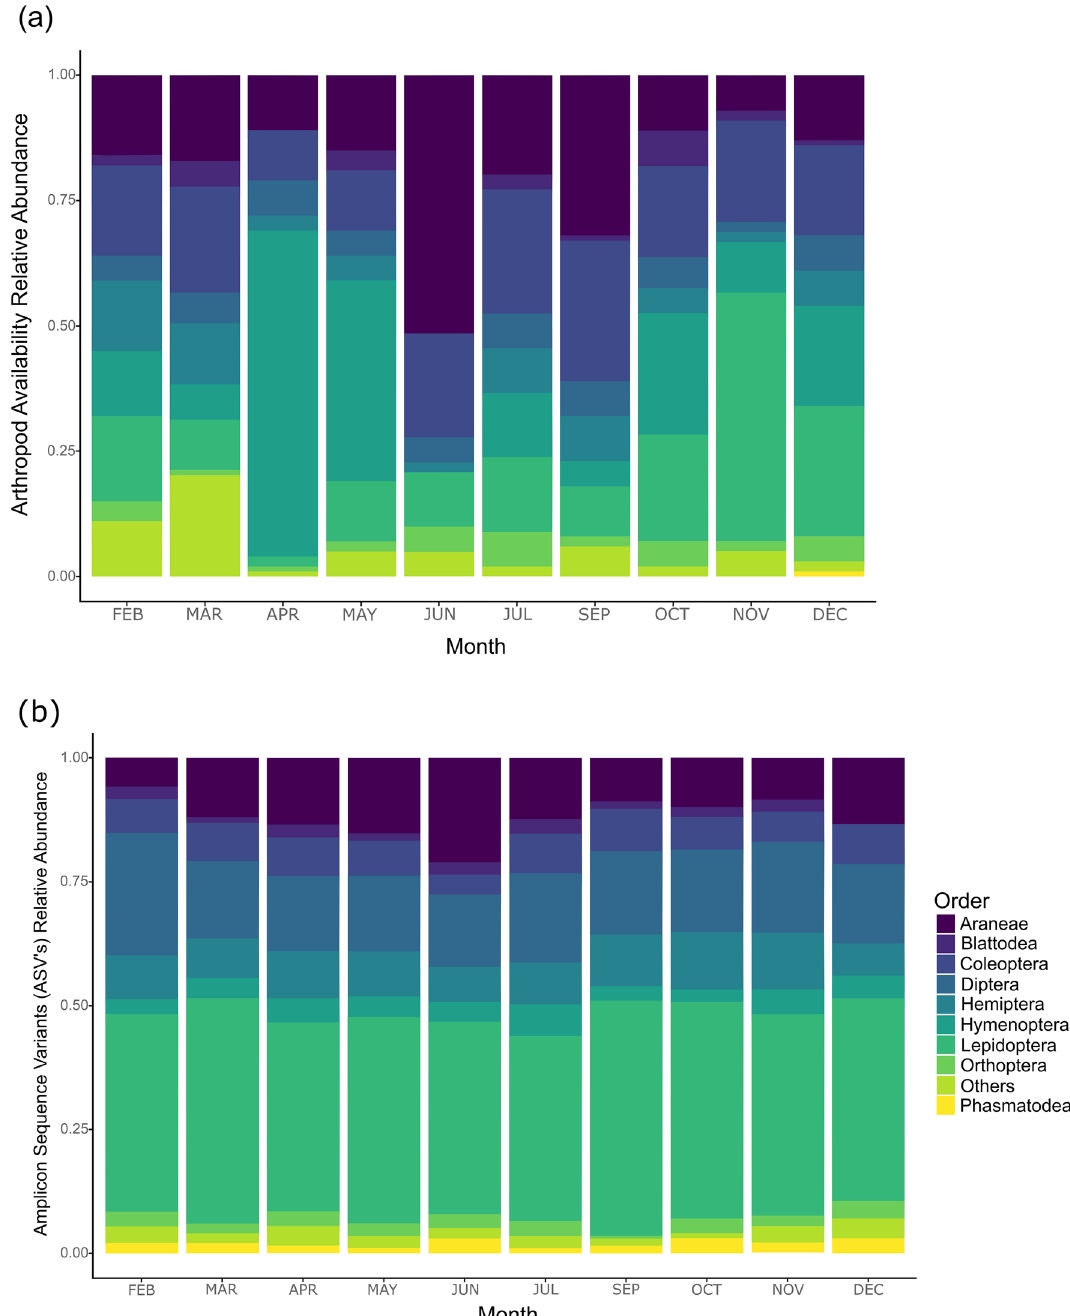
Figure 4. Arthropod abundance and consumption comparison by Colombian highland woolly monkeys ( Lagothrix lagotricha lugens ) at Cueva de los Guácharos National Park. ( a ) Results of relative arthropod abundance show the changes of different orders of arthropods during the study. Changes in composition and abundance of arthropods at Cueva de los Guácharos National Park, shows how constant humidity can harbour arthropods all over the year. ( b ) Relative abundance of arthropods Amplicon Sequence Variants (ASV) present in the woolly monkeys’ scats. Results show a constant preference during the entire study for Lepidopterans (i.e. geometer moths) and few variations in the consumption of the most relevant arthropods during the